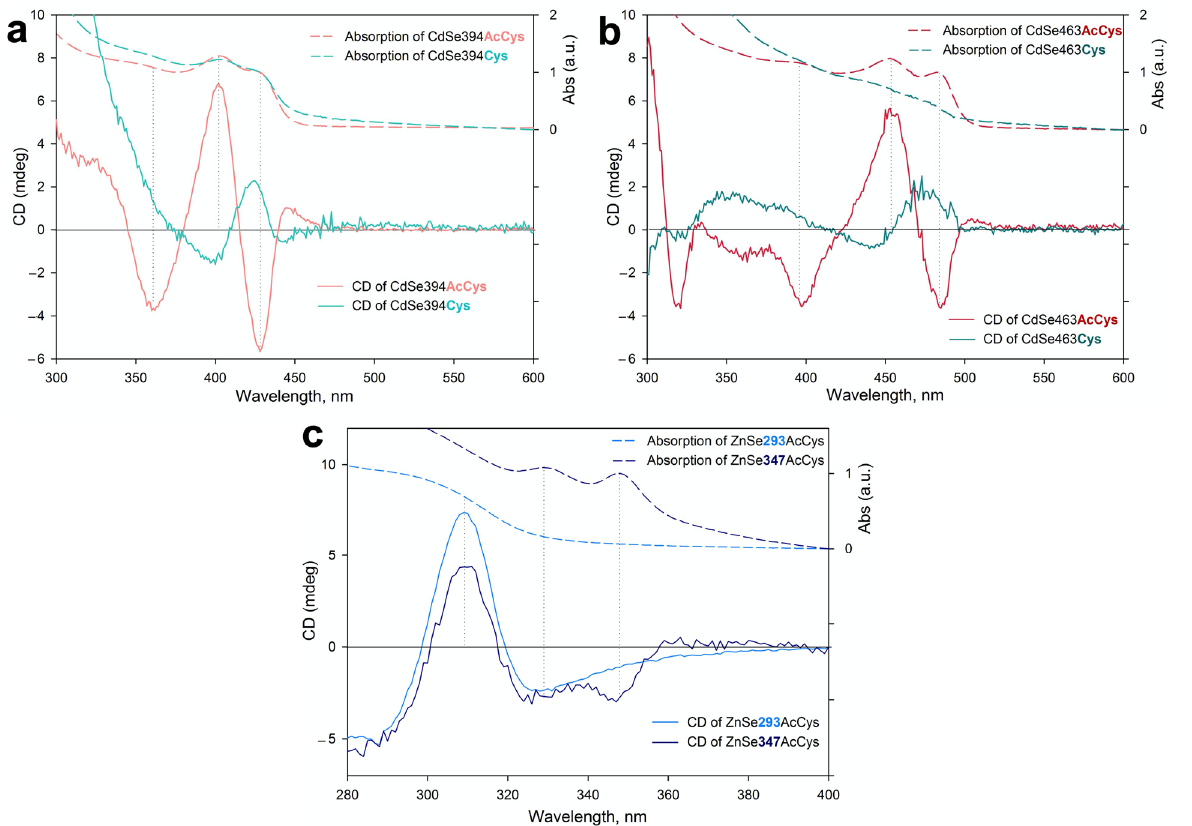
Figure 4. ( a ) CD spectra of 2.5 ML thick CdSe394AcCys and CdSe394Cys samples modified by N- acetyl-L-cysteine (pink line; L-AcCys) and L-cysteine (turquoise line; L-Cys), respectively. Absorbance spectra are shown by dashed lines for comparison. ( b ) CD spectra of 3.5 ML thick CdSe463AcCys and CdSe463Cys samples modified by N-acetyl-L-cysteine (red line; L-AcCys) and L-cysteine (green line; L-Cys), respectively. Absorbance spectra are shown by dashed lines for comparison. ( c ) CD spectra of 2.5 ML thick ZnSe293AcCys (blue line) and 4 ML thick ZnSe347AcCys (dark blue line) samples modified by N-acetyl-L-cysteine. Absorbance spectra are shown by dashed lines for comparison. Pointed lines show correspondence between CD and absorbance bands.